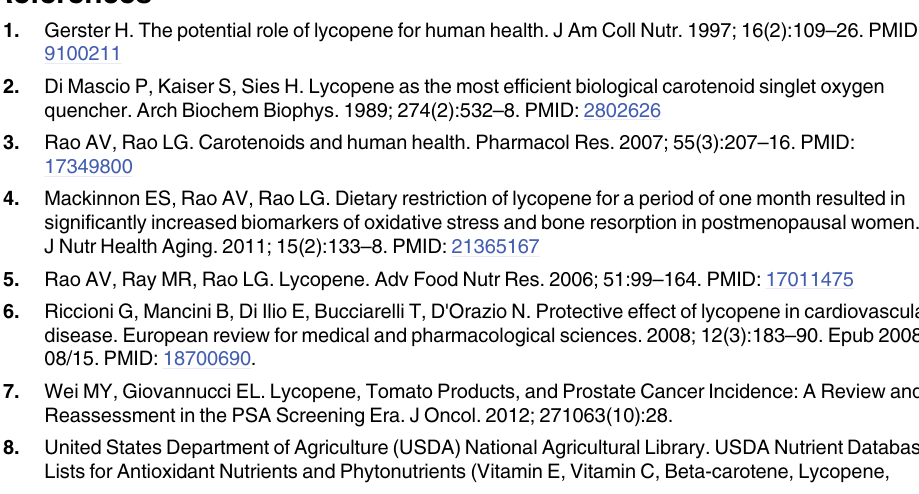
S3 Table. Correlation of food group consumption frequency with dietary α -carotene intakes and plasma α -carotene concentrations (n = 369). S4 Table. Correlation of food group consumption frequency with dietary β -carotene intakes and plasma β -carotene concentrations (n =